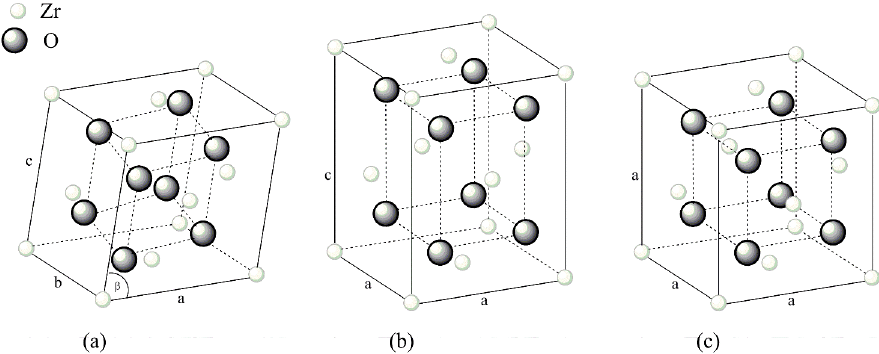
Figure 1. Schematic representation of polymorphisms of zirconia: ( a ) monoclinic, ( b ) tetragonal, and ( c ) cubic phase.